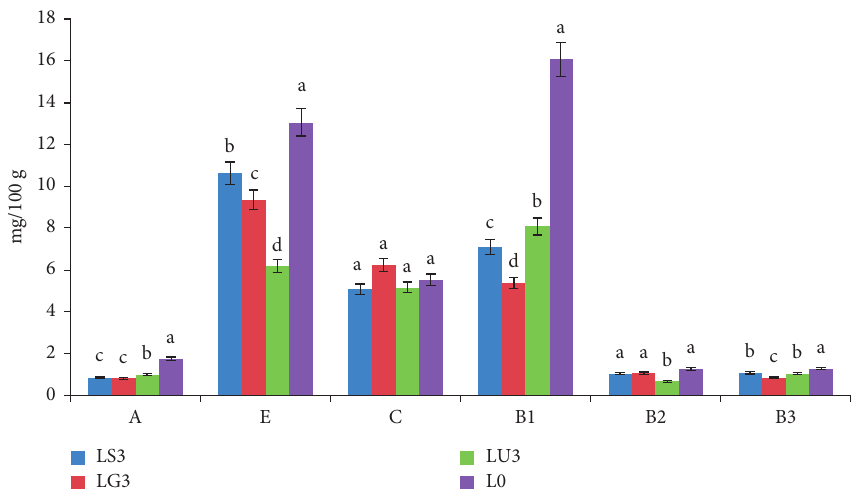
Figure 4: Vitamin content of fruit paste with 1.5% algae powder. Different letters indicate significant differences ( p < 0 . 05 ) .